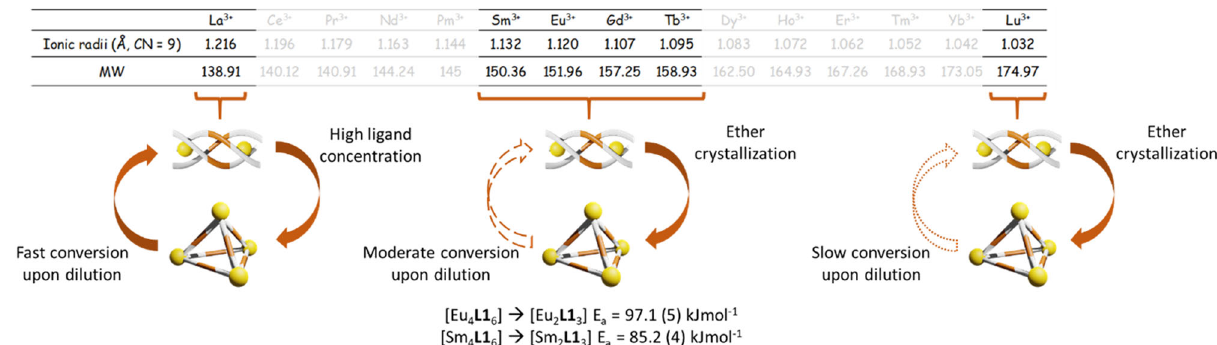
Fig. 6 Summary of helicate-to-tetrahedron transformation by different lanthanide ions. Ionic radii showed a great in fl uence on the interconvertion between helicate and tetrahedron. Largest La 3 + ion prefers to form stable helicate while smallest Lu 3 + ions can form both stable helicate and relatively stable tetrahedron assemblies. Lanthanide ions that lies between La and Lu were found to form stable helicates and upon dilution tetrahedron-to-helicate transformation was observed. Both [Eu 4 L1 6 ] and [Sm 4 L1 6 ] exhibited similar activation energy under the tetrahedron-to-helicate transformation process.